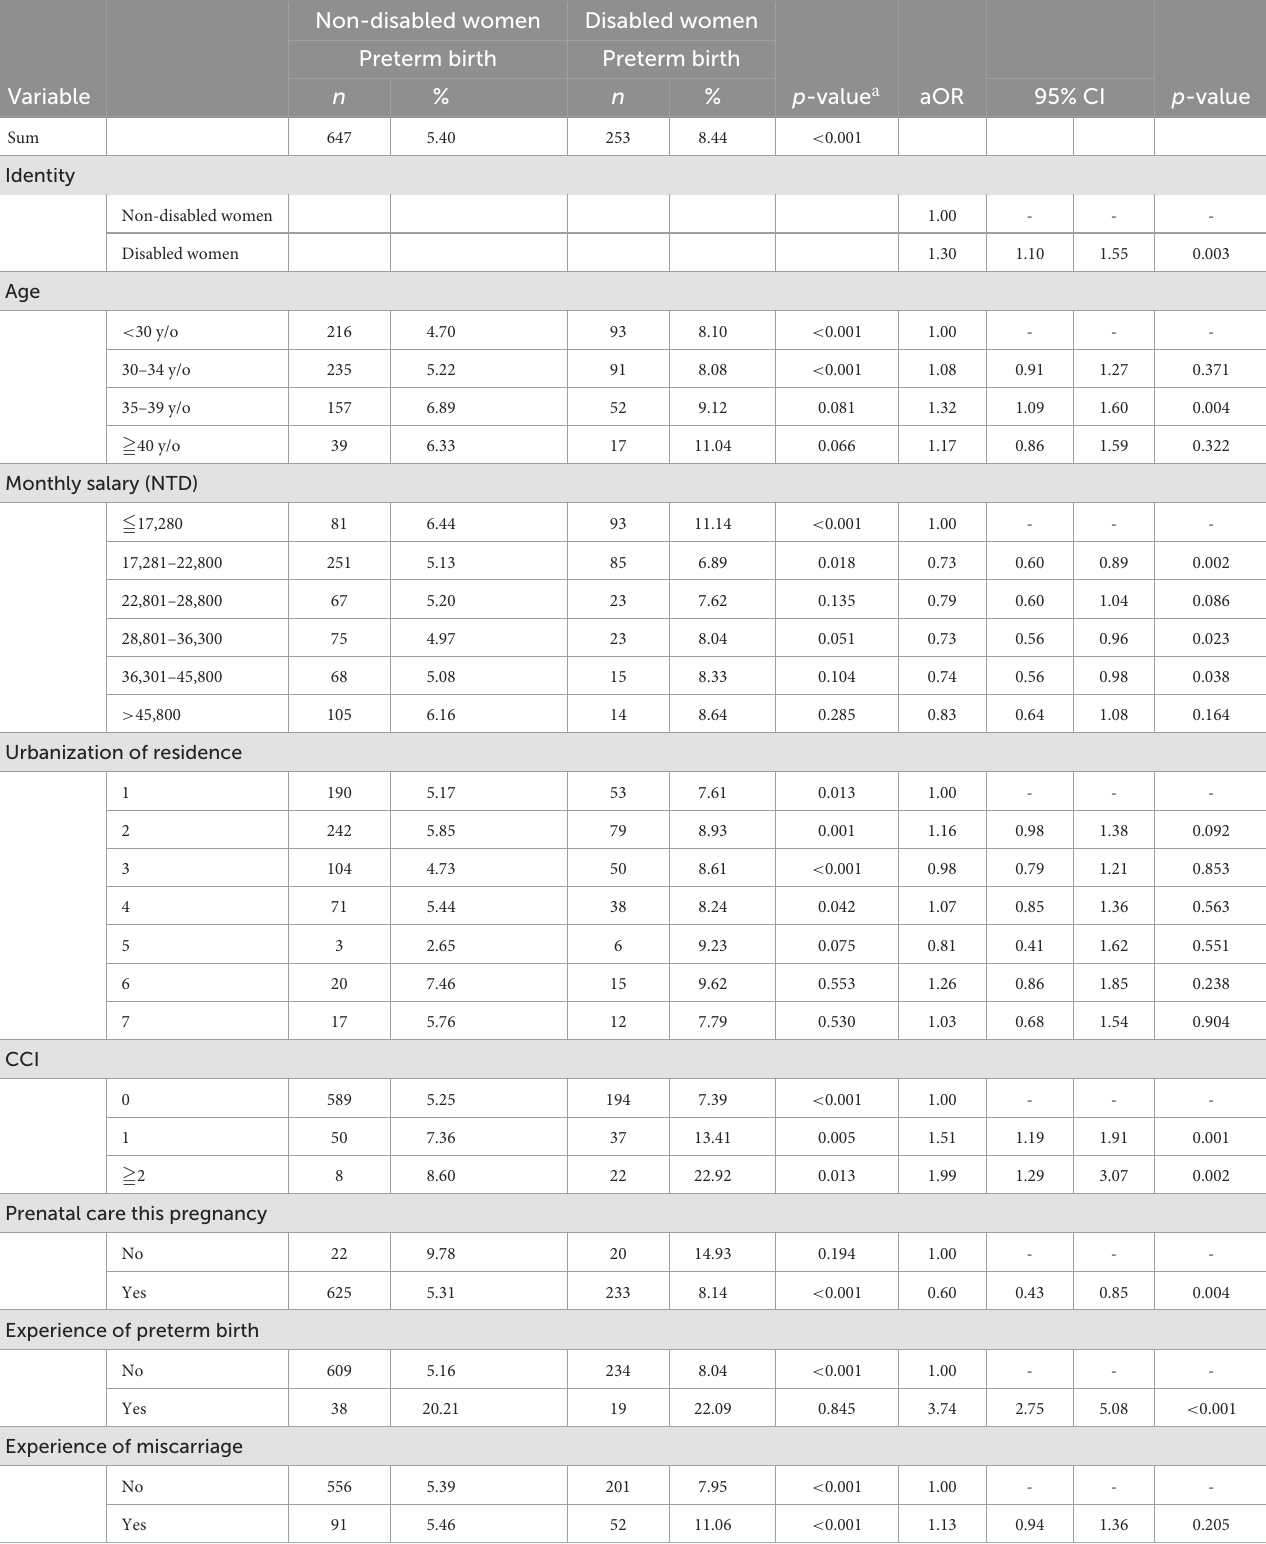
TABLE 3 Comparison of the risk of preterm birth between disabled pregnant women and non-disabled pregnant women. Non-disabled women Disabled